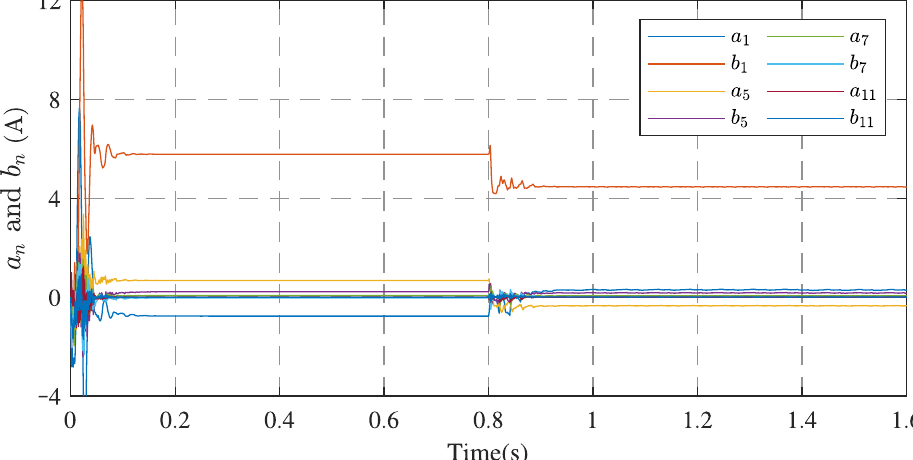
Figure 9. The values of each harmonic parameter extraction with frequency and amplitude jump.